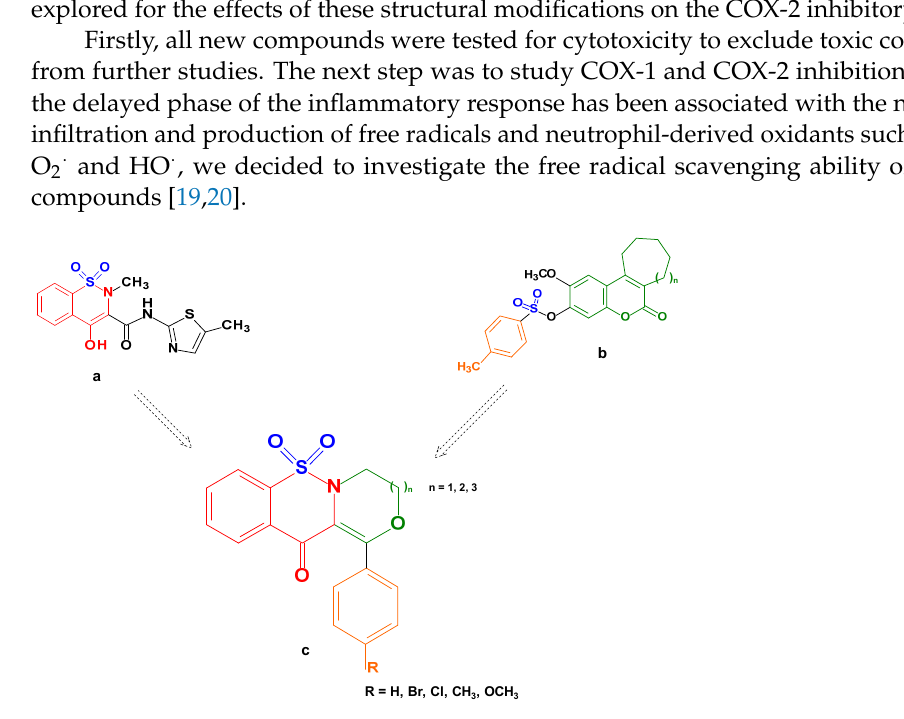
Figure 3. Structures of meloxicam ( a ), El-Gamal’s compounds ( b ) and the designed new compounds ( c ).